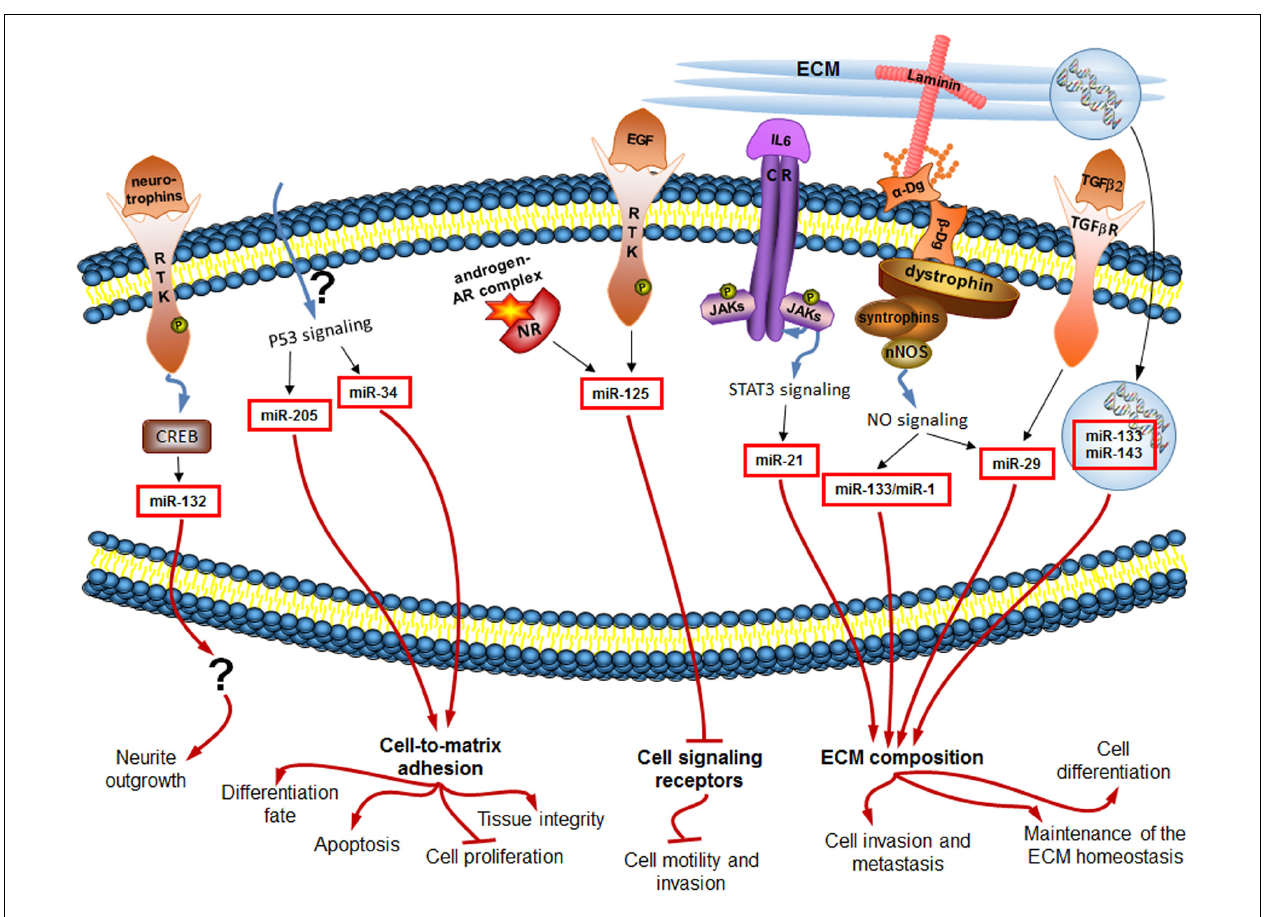
FIGURE 2 | miRNAs regulated downstream of signaling induced by changes in the extracellular environment (black arrows) influence in turn the ECM composition and the cellular sensory apparatus, and ultimately the cell behavior (red arrows). Only mammalian miRNAs and pathways are